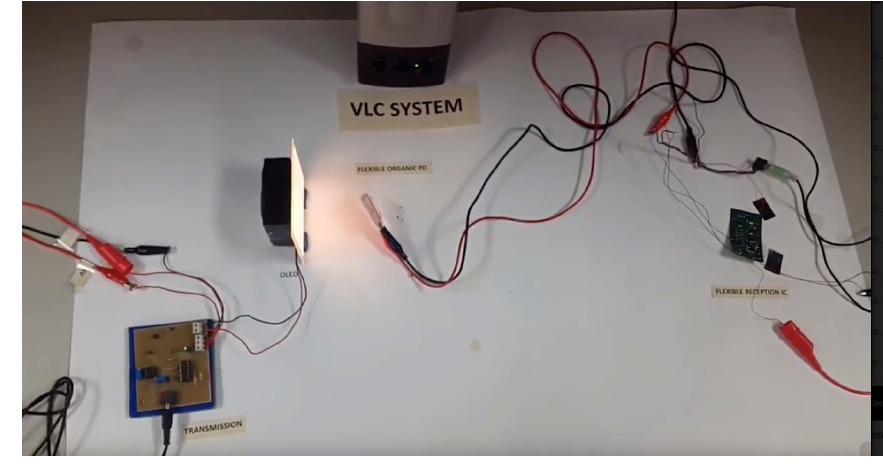
Figure 11. View of the proof of concept VLC built in lab.